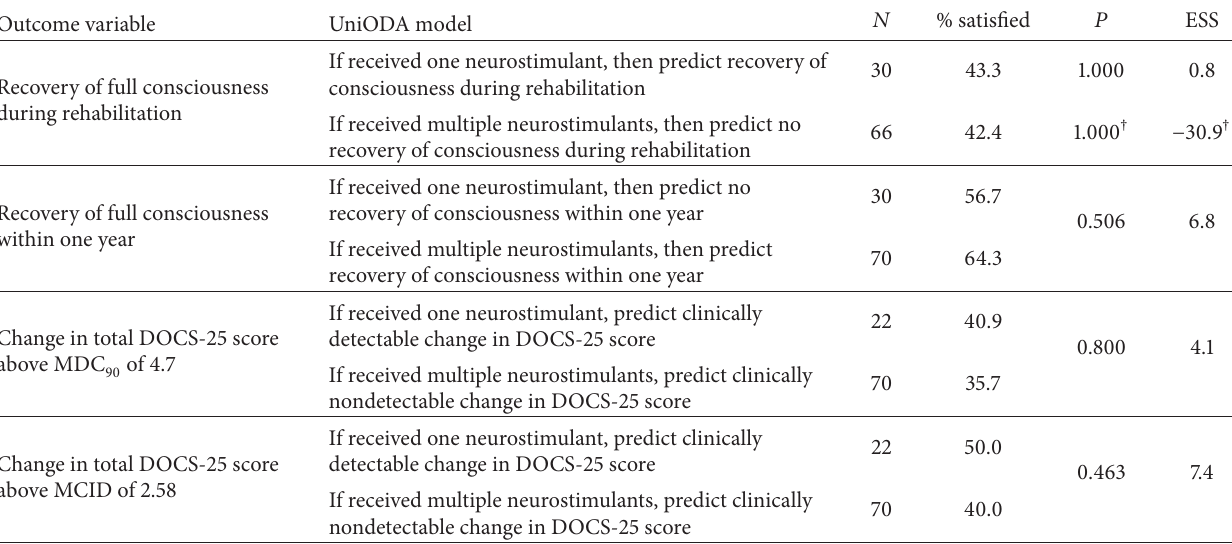
Table 3: Univariate optimal data analysis (UniODA) results, neurostimulants as explanatory